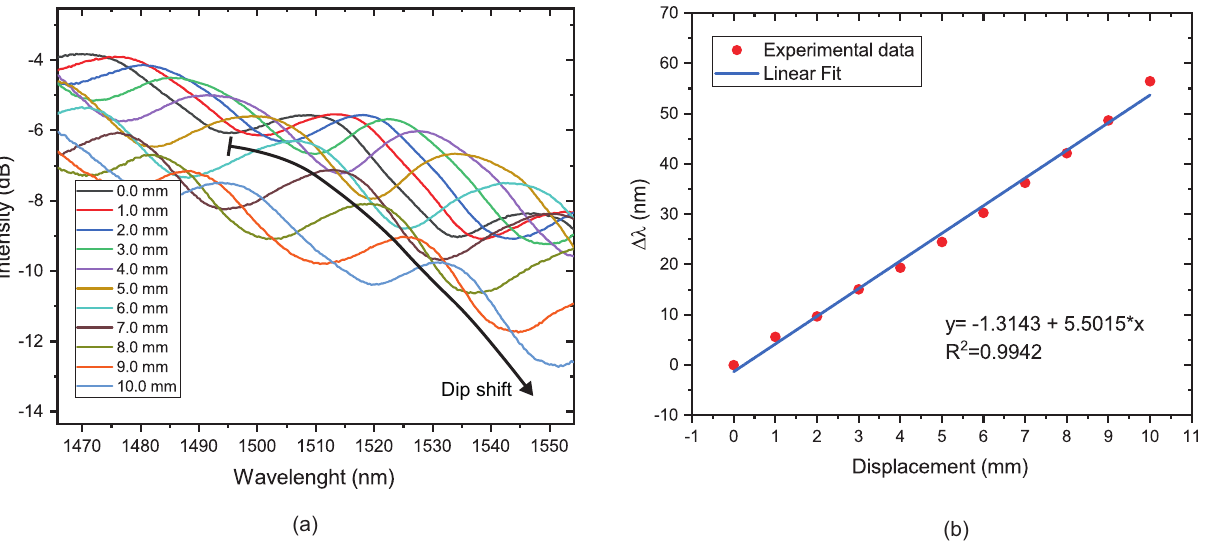
Figure 9. ( a ) Transmission spectra of the proposed prototype. ( b ) The relationship between displace- ment applied in the 3D piece and resonant